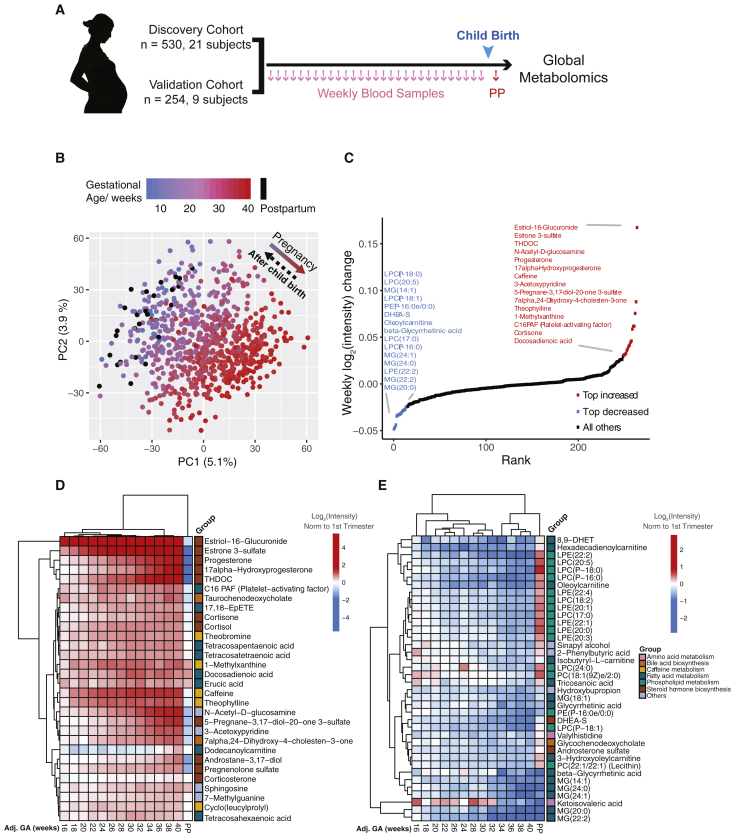
Untargeted Metabolomics Cluster the Weekly Plasma Samples Precisely According to Gestational Age(A) Sampling scheme. Note that validation cohort refers to test set 1 in Table 1.(B) Principal component analysis (PCA) distributed individual samples according to pregnancy stages (based on 9,651 features). The two PCs explaining the largest part of the variation are shown.(C) Plot shows the top 15 increased (red) and decreased (blue) metabolites (with MSI level 1 or 2 identification) in pregnancy.(D and E) Heatmap displays the metabolite signal intensity averaged across individuals, showing the top 68 altered metabolites (D) increased and (E) decreased by the end of pregnancy. Abbreviations are as follows: PP, postpartum. The gestational ages (GAs) were calculated by scaling delivery events to 40 weeks. The week order, which mostly coincides with the actual order, was ordered by hierarchical clustering on the basis of Manhattan distances. The intensities averaged before 14 weeks of all women were used as the baseline.See also Figure S1 and Table S1.